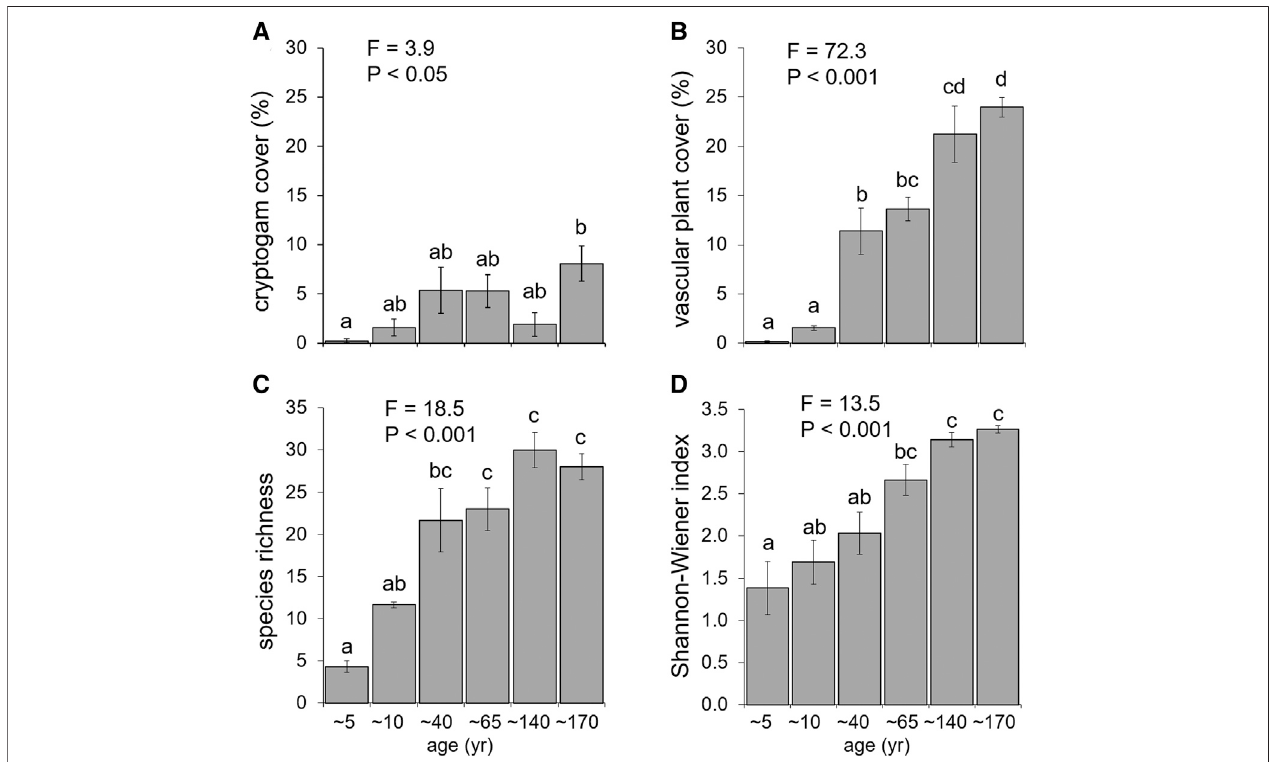
FIGURE 2 | Plant species cover ( (A) , cryptogams; (B) , vascular plants) and diversity indexes ( (C) , species richness; (D) , Shannon-Wiener index) along the six stages of the chronosequence. Different letters indicate signi fi cant differences ( p < 0.05) among stages according to Tukey ’ s HSD